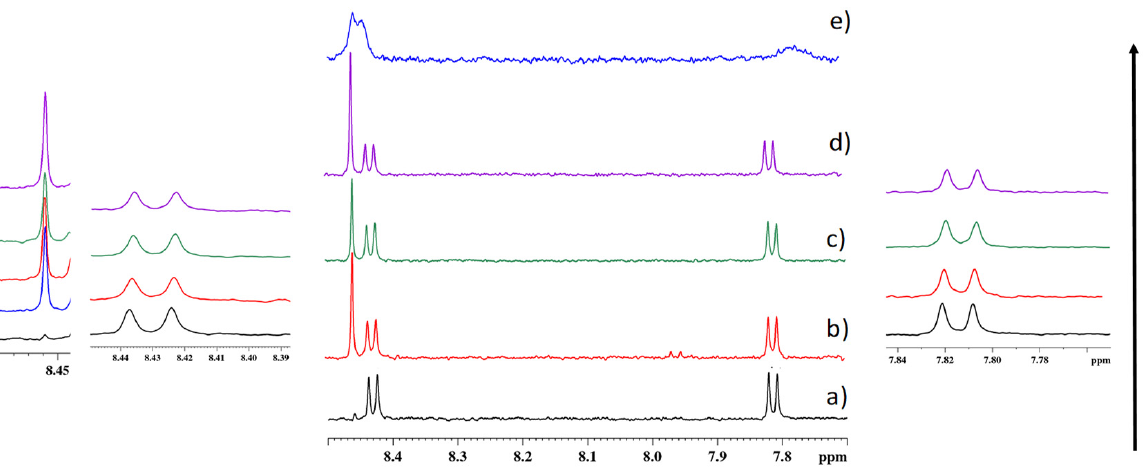
Figure 6. The 1 H NMR spectra of PTAS at different metal ion ratios in D 2 O at 600 MHz. ( a ) A 30 µ M PTAS solution; ( b ) 30 µ M PTAS and 15 µ M Cu 2+ solution (PTAS:Cu 2+ = 2:1); ( c ) 30 µ M PTAS and 30 µ M Cu 2+ solution (PTAS:Cu 2+ = 1:1); ( d ) 30 µ M PTAS and 60 µ M Cu 2+ solution (PTAS:Cu 2+ = 1:2); ( e ) 30 µ M PTAS and 120 µ M Cu 2+ solution (PTAS:Cu 2+ = 1:4).